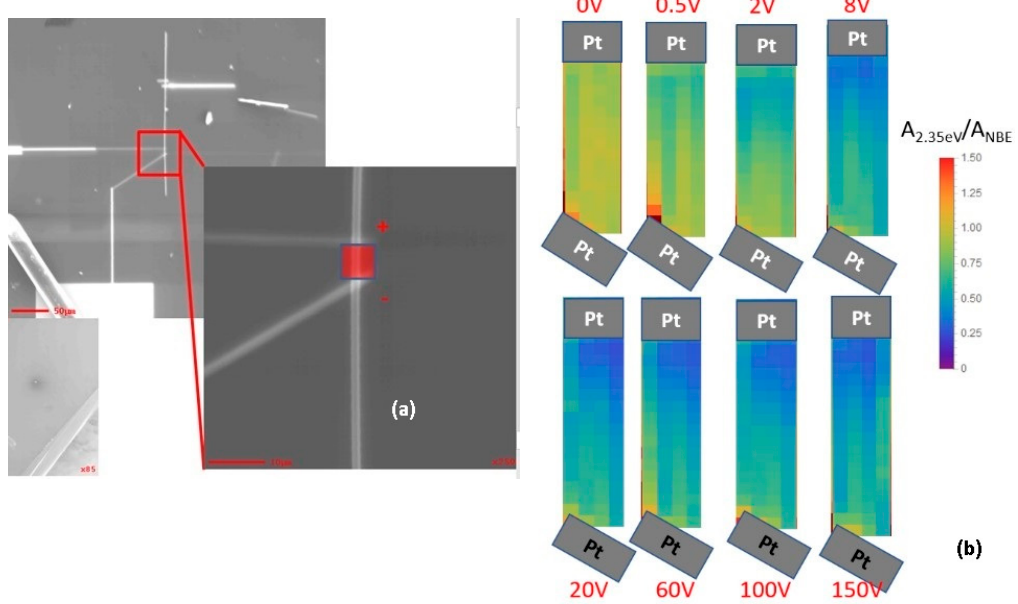
Figure 12. ( a ) Pt wire layout to apply voltage across two Pt contacts spaced 5 µ m apart on a 3 µ m diameter ZnO nanowire. ( b ) HSI maps of normalized defect intensity between Pt electrodes showing segregation of defects toward bottom electrode increasing with increasing applied voltage [60].